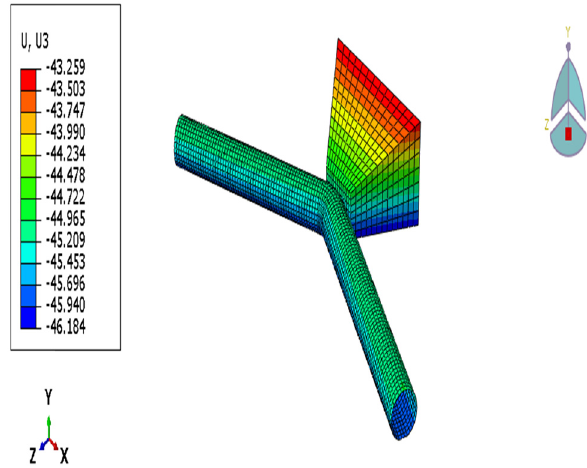
Figure 10: Horizontal displacement of thrust block ( mm )